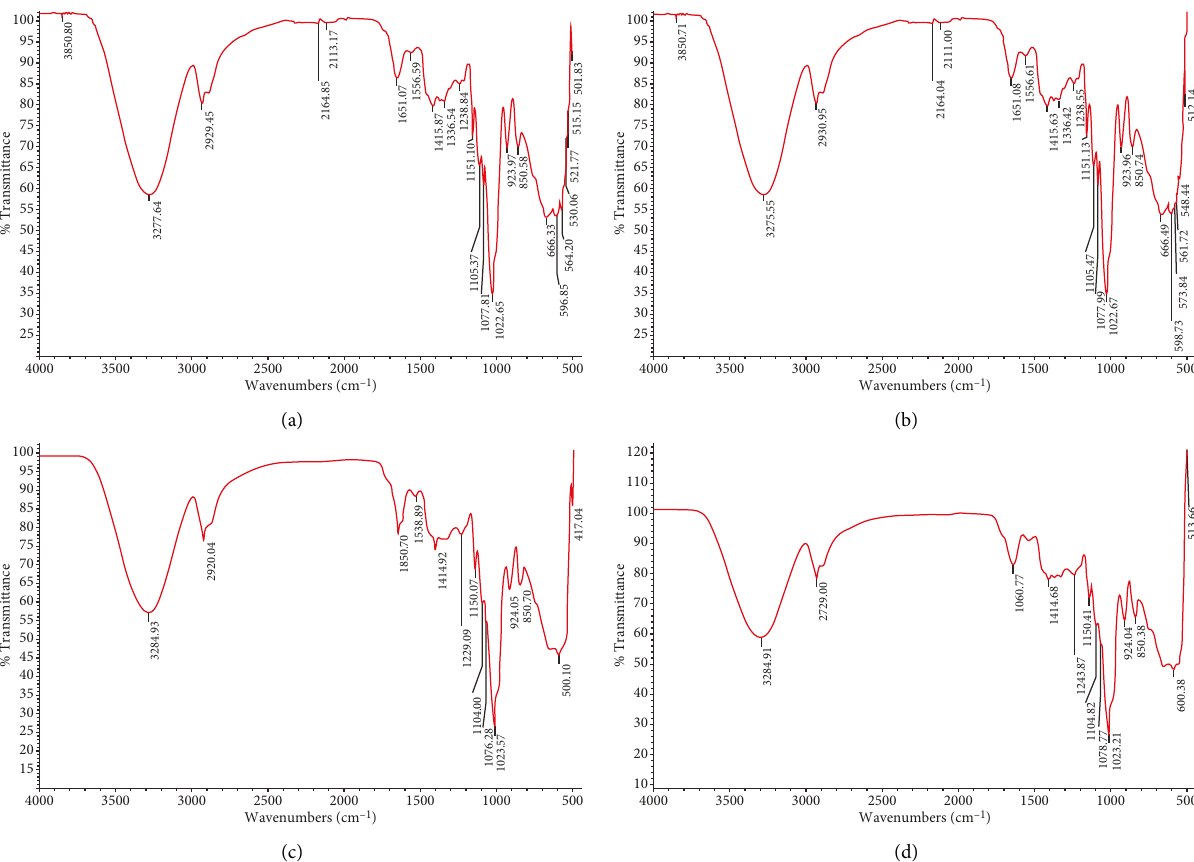
Figure 3: FTIR spectra of (a) cornmeal, (b) the film made from cornmeal in the presence of vinegar, (c) the film made from cornmeal in the presence of distilled vinegar, and (d) the film made from cornmeal in the presence of acetic